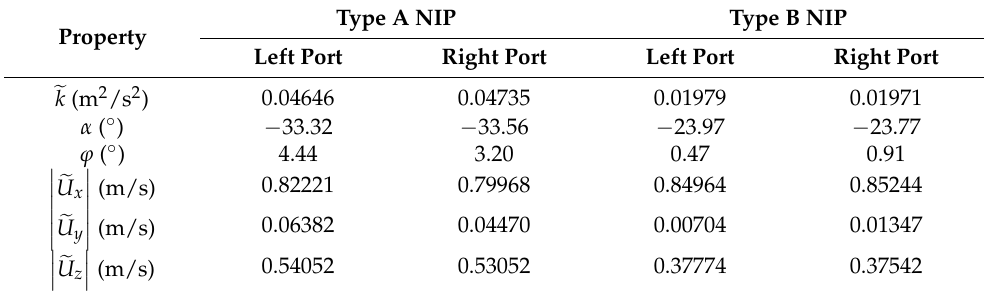
Table 3. Average turbulent kinetic energy and velocity direction angles for the two different nozzles.